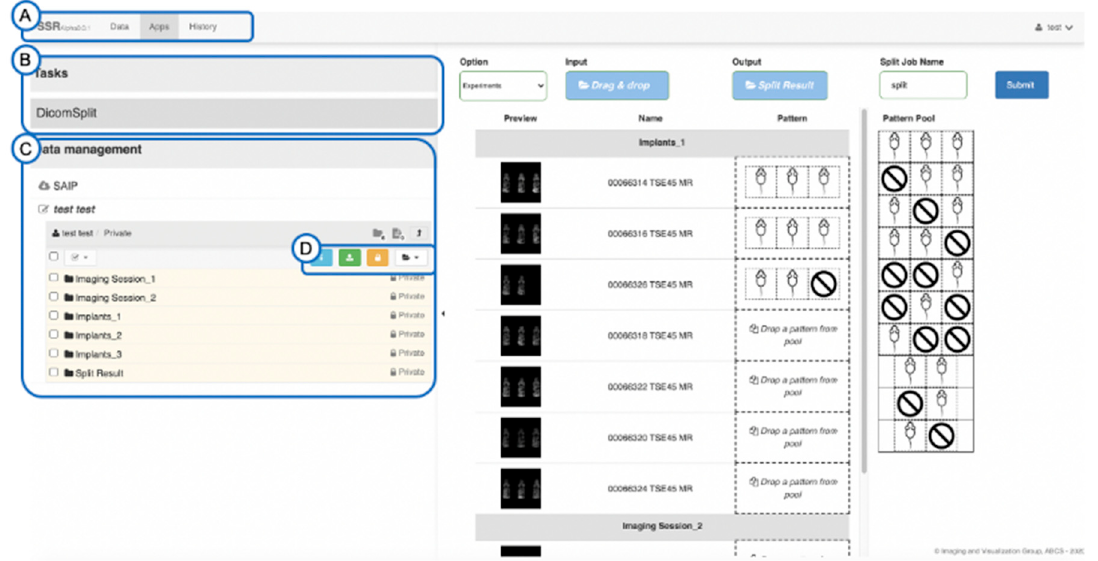
Figure 1. Graphic User Interface (GUI) for batch processing of multi-mouse DICOM images. ( A ) The Navigation Tab for Data Management, Tasks (Workflows) Execution, and Record Checking, ( B ) Available Tasks (DicomSplit task is shown as an example), ( C ) The Data Management Panel for data selection (DICOM PACS server or workstation), ( D ) Data Manipulation Actions provided by Girder [27] for image upload, download, and folder creation.